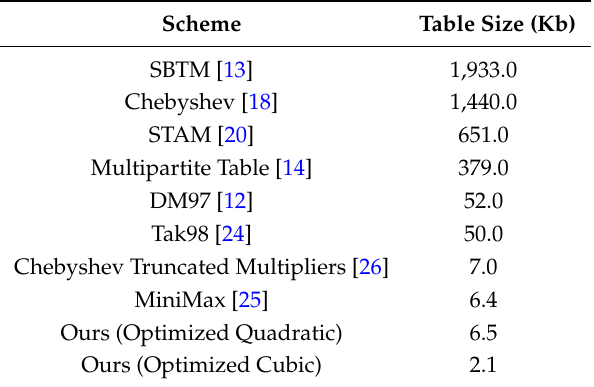
Table 7. Table size comparisons for f ( x ) = 1/ x at 24-bit accuracy.